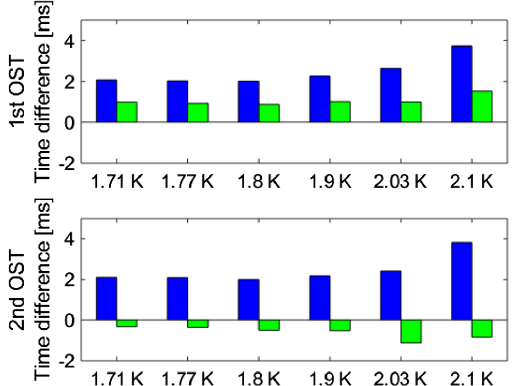
FIG. 19. Difference between calculated and measured times of arrival of the 2nd sound signal on the two closest OSTs from the quench location with varying temperature for Test 4. Calculation with direct line of sight propagation (blue) and calculation with the mixed niobium/helium heat propagation model (green). At 2.1 K the reference measured value is the average between the two real measured values shown in Fig.